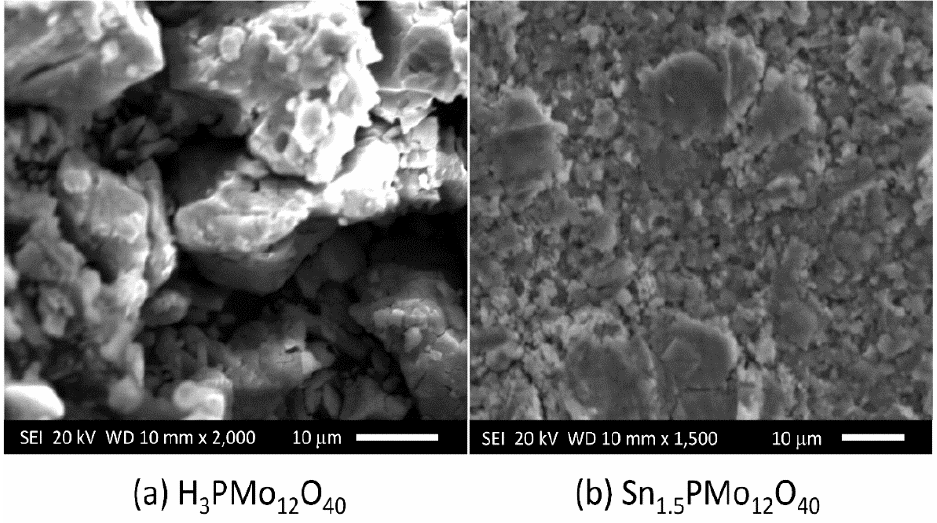
Figure 2. SEM images of ( a ) Precursor H 3 PMo 12 O 40 and ( b ) Sn 1.5 PMo 12 O 40 catalyst. As verified by the Sherrer equation, the particle size of Sn 1.5 PMo 12 O 40 was smaller than pristine acid. From the N 2 adsorption/desorption isotherms (Figure 3), the surface properties of tin phosphomolybdate were obtained. Table 2 shows that they were very close to those obtained from phosphomolybdic acid.